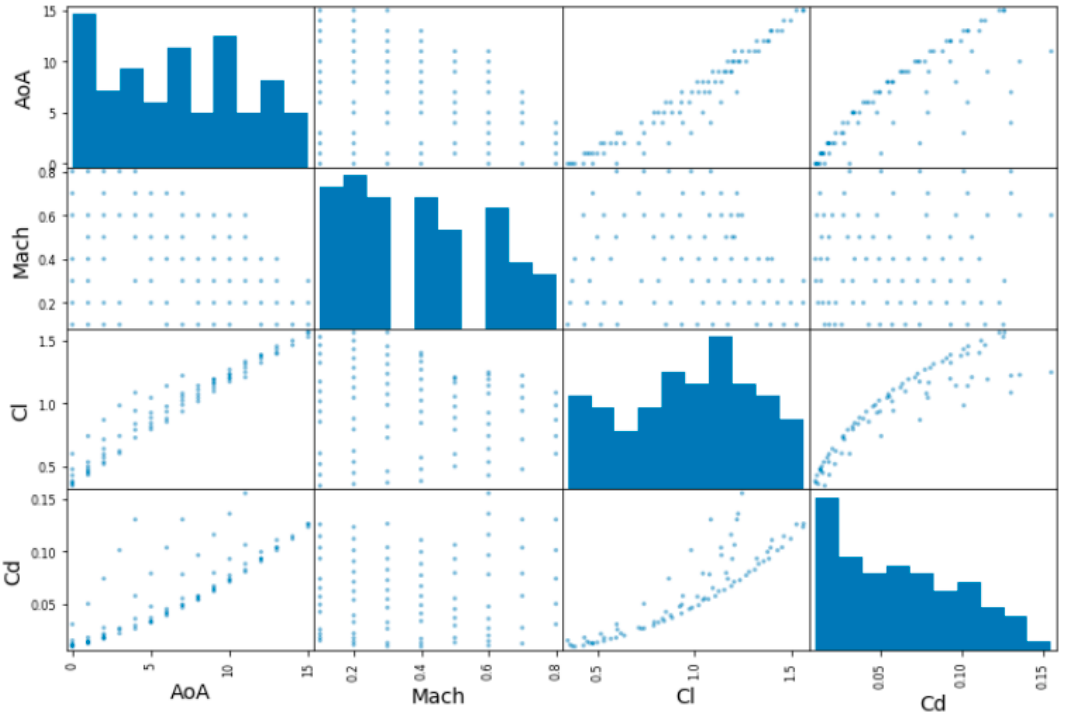
Figure 8. Exploring training set in the DPW database (correlation matrix plot).